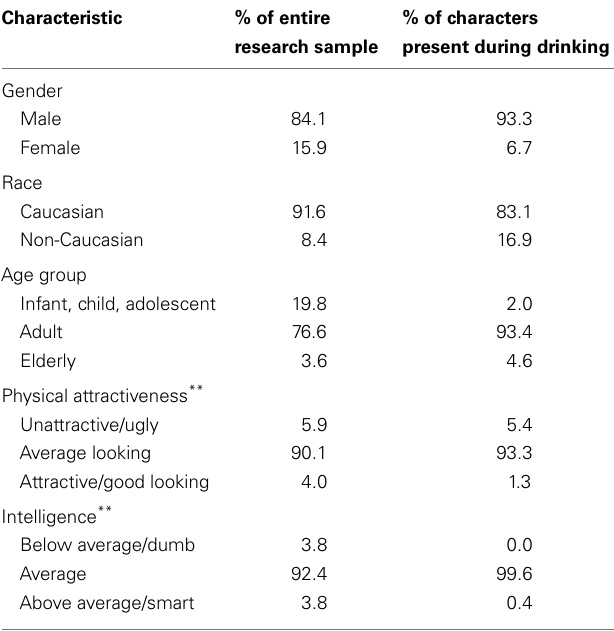
Table 2 |A comparison of selected characteristics of the cartoon sample overall and the characters that were present when alcohol was consumed in cartoons *